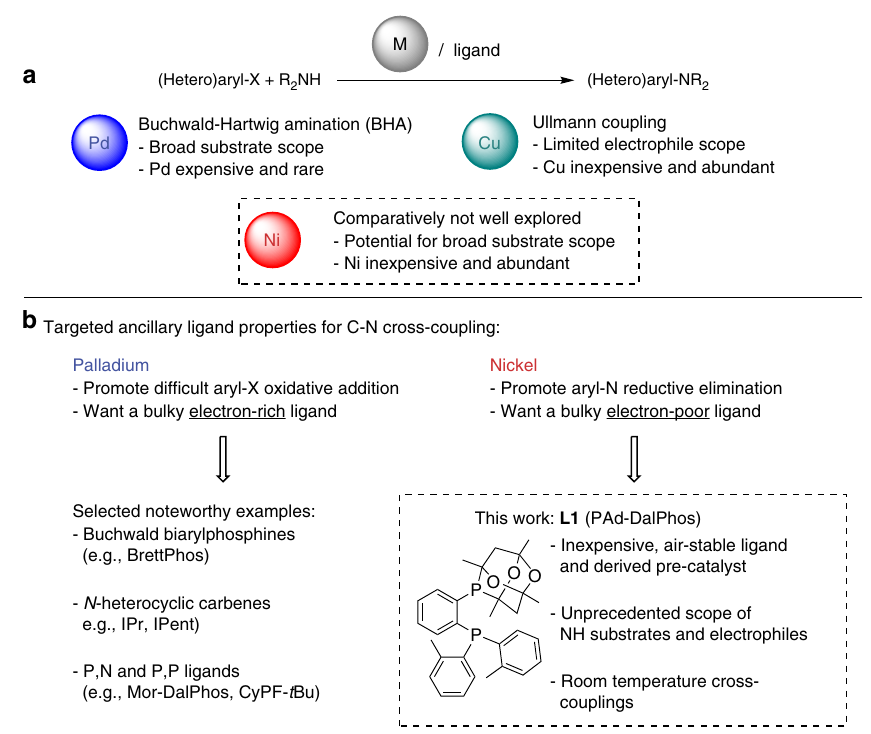
Figure 1 | Approaches to metal-catalysed C–N cross-coupling. ( a ) Generic equation for Buchwald–Hartwig amination and Ullmann C–N coupling to form a (hetero)aniline. ( b ) Ancillary ligand design strategies for palladium and nickel, along with the new ancillary ligand L1